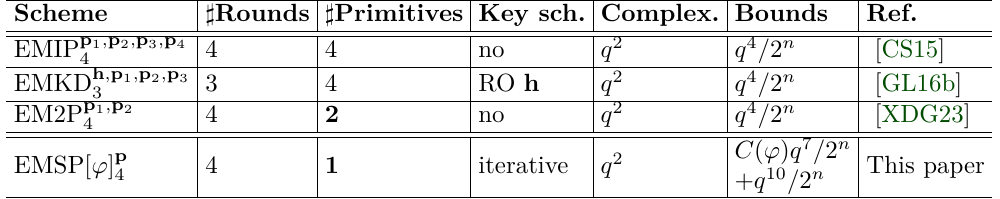
using a single random permutation 4 for a fixed integer a . a , C ( φ ) = 1 for linear 4 , 1 ≤ a ≤ n/ 2. a